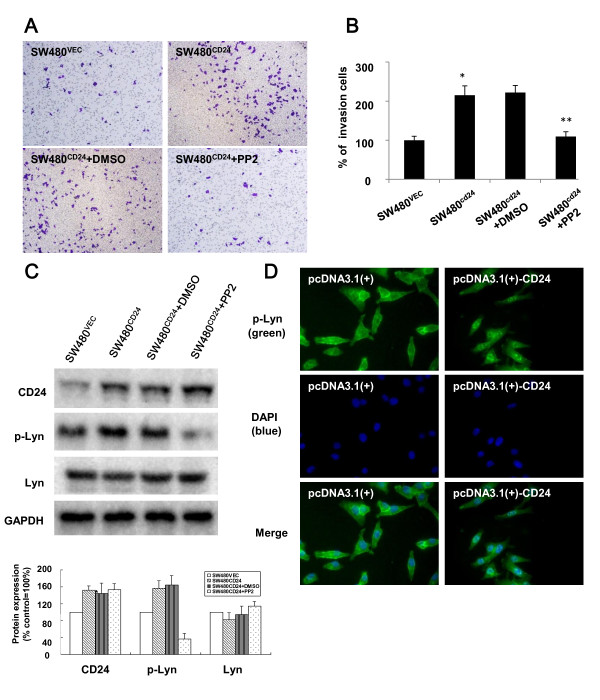
Inhibition of Lyn activation attenuated CD24-induced CRC cell invasion. A. Representative images from the cell invasion assay. SW480CD24 cells or vehicle control cells were seeded into transwell chambers coated with Matrigel and 10 μM PP2 was added 24 h later and kept for 30 min. The cell invasion assay was performed at 24 h after PP2 treatment. CD24 increased the capacity of SW480 cells to migrate through the filters compared with the controls cells (upper). Furthermore, the migration capacity of the SW480CD24 cells that were treated by PP2 (10 μM) was inhibited (bottom). B. Quantification of cell invasion. Invasive activity was determined as the percent invasion of the control SW480 cells through the Matrigel membrane. Values shown are means ± standard errors (SE) for three independent experiments. * P < 0.05 between SW480VEC and SW480CD24 cells; ** P < 0.05 between (SW480CD24 + DMSO) and (SW480CD24 + PP2) cells. C. Western blotting analysis showed the phosphorylation of Lyn was induced by the over-expression of CD24 (lane 2) and the activation of Lyn was inhibited by PP2 (lane 4). GAPDH served as a loading control. Bar graph depicted the quantitative analysis for protein expression and the expression of each protein was normalized to GAPDH. D. Immunofluorescent staining of cells transfected with a pcDNA3.1(+)-CD24 plasmid. SW480 cells were transfected with a CD24 expression plasmid or vehicle control. After 24 h, cells were fixed, permeabilized and stained with 4,6-diamidino-2-phenylindole (DAPI; blue) and Lyn (green). In the cells with overexpressed CD24, Lyn was activated. phospho-Lyn was more intense in the nucleus.